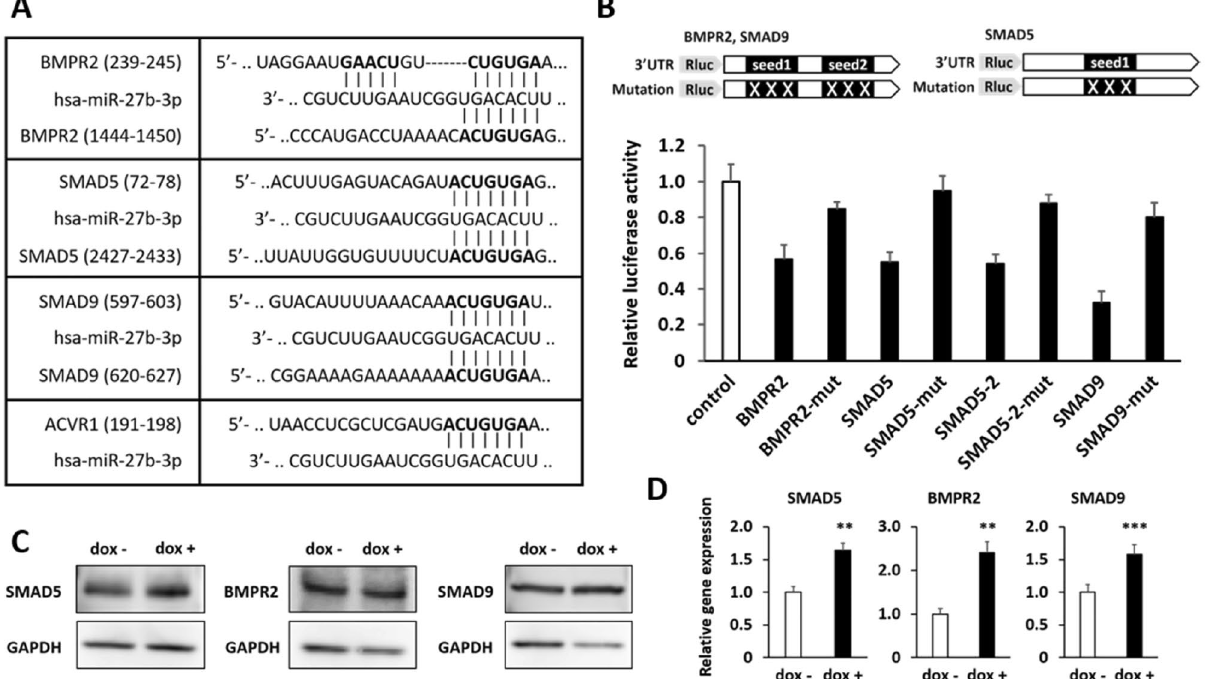
Figure 4. miR-27b indirectly regulated the BMP signaling pathway. ( A ) Predicted pairings of the 3 ′ UTRs of target genes to miR-27b-3p are aligned. ( B ) Luciferase reporter plasmids were co-transfected with pHM-U6- pre-miR-27b into HEK293 cells, and luciferase activity was measured 48 h after transfection. The data from cells co-transfected with the control reporter vector without any 3 ′ UTR fragment downstream of Renilla luciferase gene are taken as 1.0. Data are presented as mean ± SD (N = 3). The student’s t test was performed (***p < 0.001). Experiments were performed twice in triplicate. The representative result from two independent experiments is shown. ( C , D ) hiPS-AAVS1-27b cells were differentiated into mesensoderm as in Fig. 2A with or without dox (1 µg/ml). Protein ( C ) and mRNA ( D ) expression levels of BMPR2, SMAD5 and SMAD9 in the cells at day 2 (mesendoderm) were analyzed by Western blotting and qRT-PCR, respectively. Original images of Western blotting are shown in Fig. S8C. The value of dox- are taken as 1.0. Data are presented as mean ± SD (N = 3).